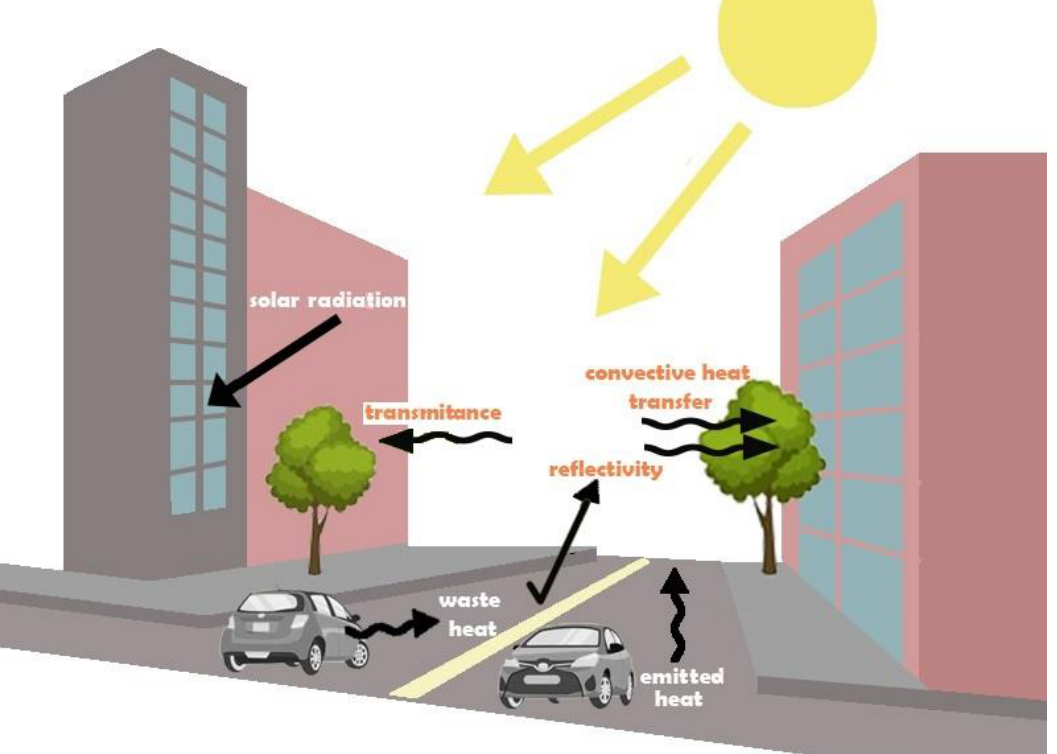
Figure 1. Main heat flows (white font) and parameter that influence the heat flows (orange font) of an urban heat island.